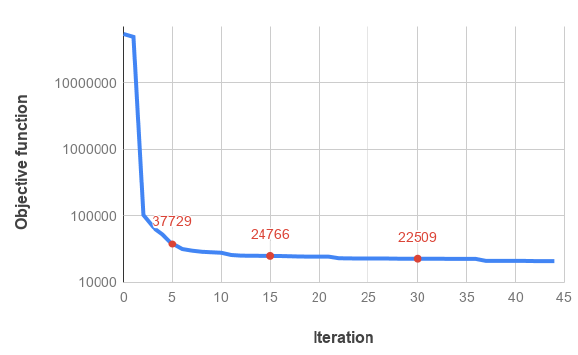
Figure 5. Objective function values vs. the iteration number for the SGP execution on the phantom test. The convergence has been reached after 44 iterations by satisfying condition (29). The red labels outline the function values at 5, 15 and 30 iterations.